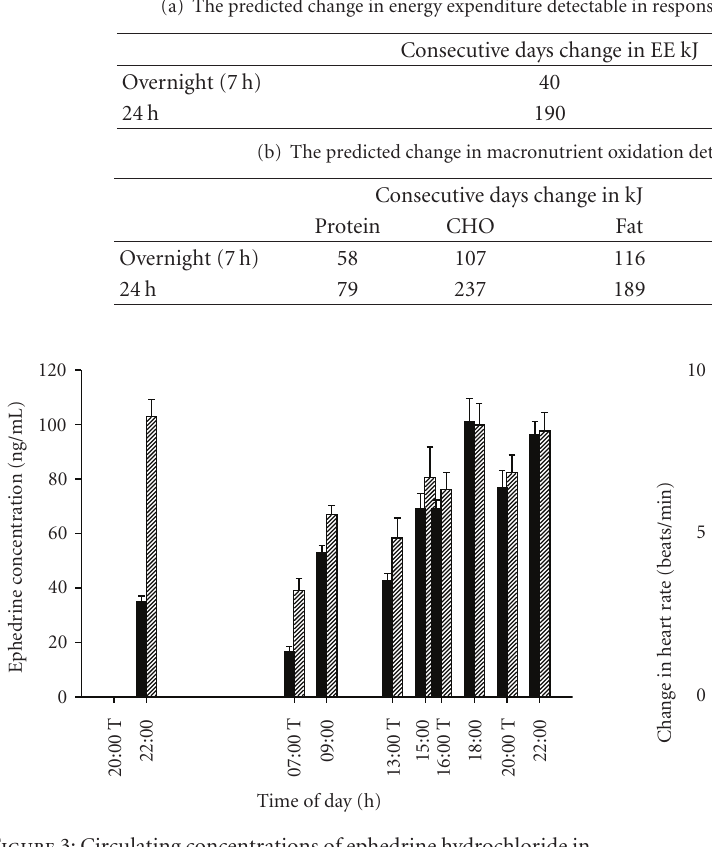
Figure 3: Circulating concentrations of ephedrine hydrochloride in treated subjects ( n = 8). Solid bars: days 1-2; hatched bars days: 14- 15. T indicates administration times.